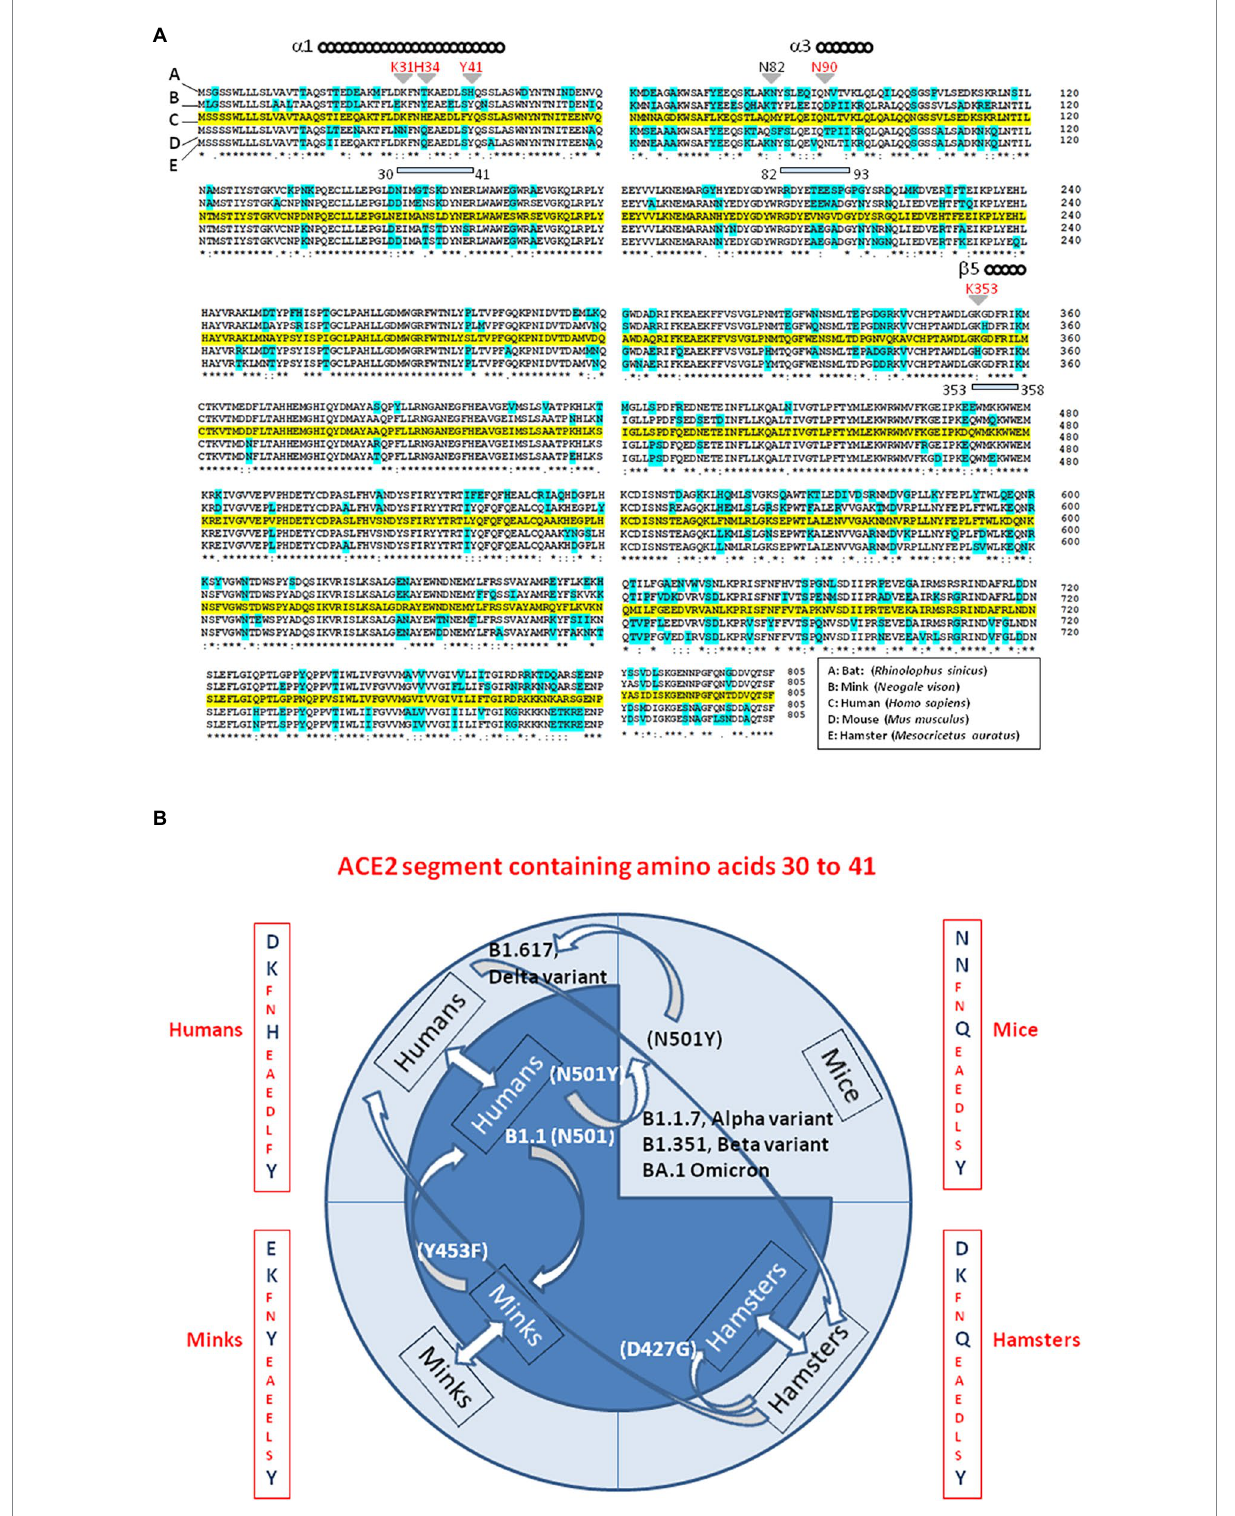
FIGURE 6 Interspecies viral circulation. (A) ACE2 multiple sequence alignment. The consensus ACE2 sequence from humans ( Homo sapiens ; GeneBank BAB40370.1) was compared to ACE2 sequences from mink (Neogale vison NCBI ref. sequence XP_044091953.1), hamsters ( Mesocricetus auratus ; NCBI ref. sequence XP_005074266.1), mice ( Mus musculus ; NCBI ref. sequence NP_081562.2), and bats ( Rhinolophus sinicus ; GeneBank: AGZ48803.1), using the Clustal Omega multiple sequence alignment (EMBL-EBI bioinformatic tool; Copyright © EMBL